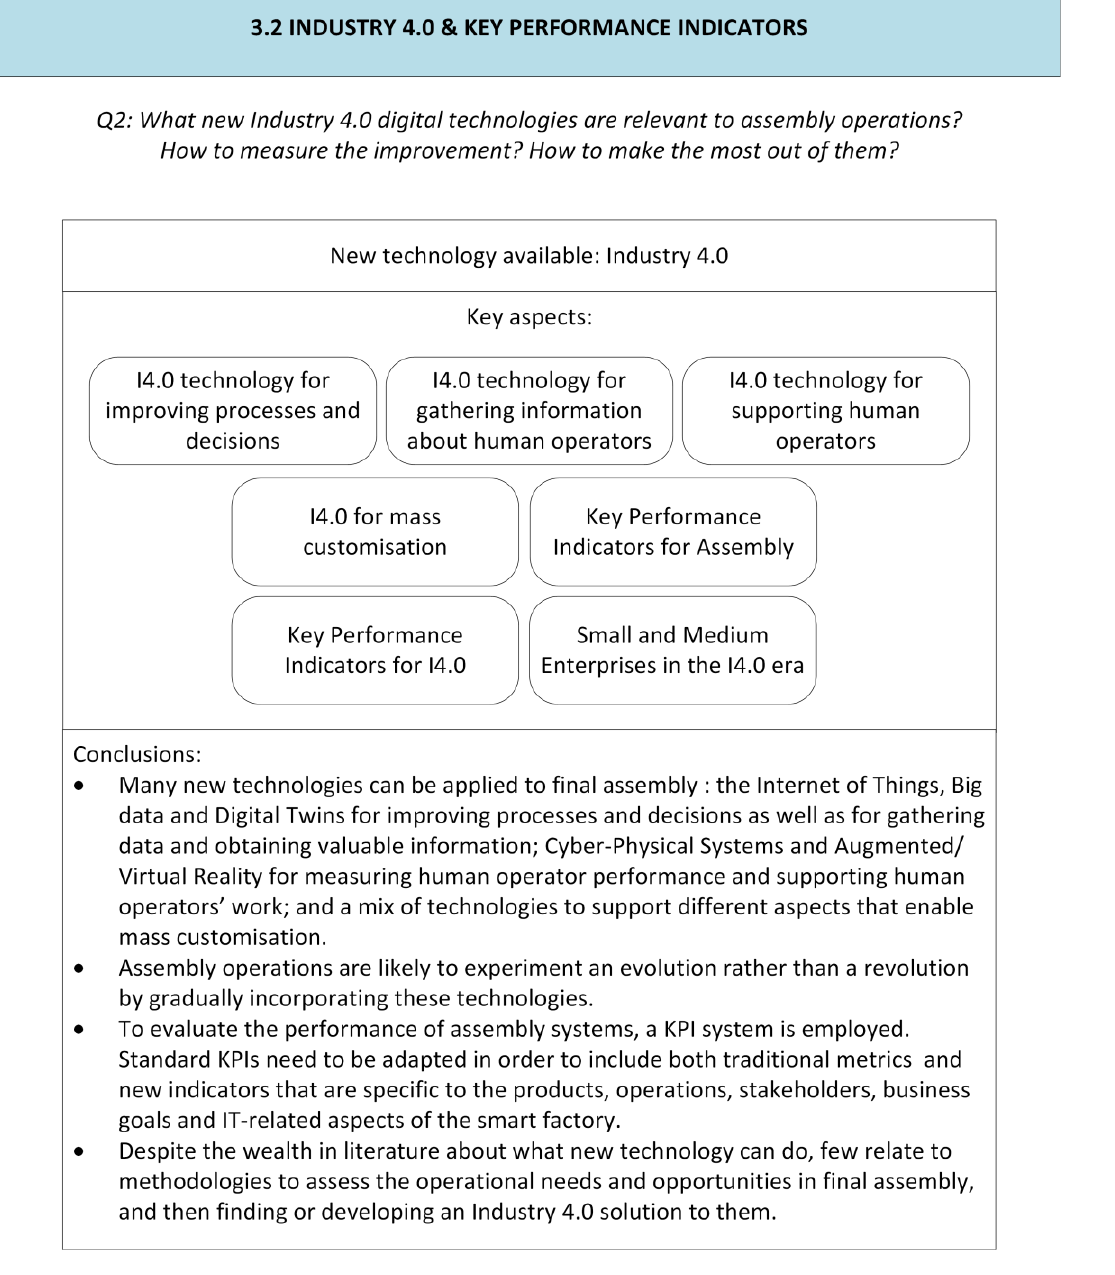
Figure 6. Key aspects of Industry 4.0 technologies for assembly operations and Key Performance Indicators (KPIs), and main conclusions of the analysis.